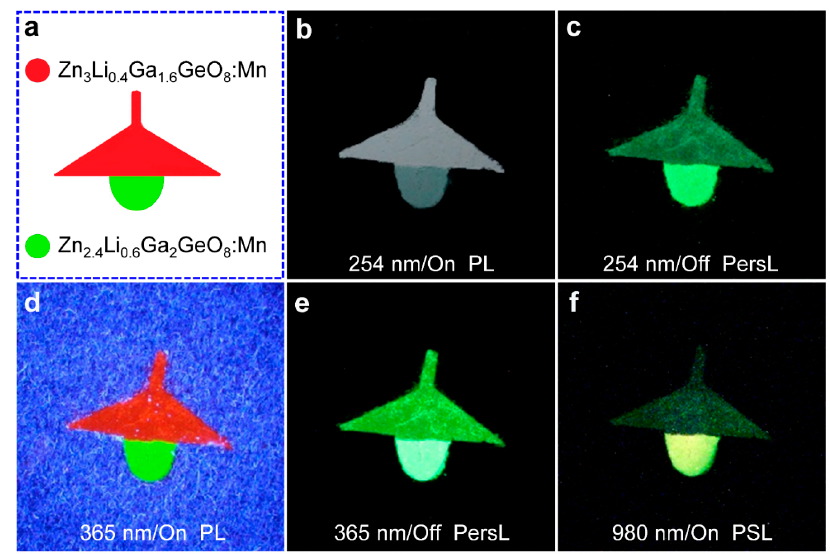
Figure 8. Digital photographs of a triple-mode (PL, PersL, and PSL modes) ‘chandelier’ pattern printed used Zn 3 Li 0.4 Ga 1.6 GeO 8 :Mn phosphor (lampshade) and Zn 2.4 Li 0.6 Ga 2 GeO 8 :Mn phosphor (light bulb) synthesized by hydrothermal approach. ( a ) The design of the ‘chandelier’ pattern; ( b , c ) PL and PersL images acquired upon and after 254 nm UV light excitation (for 5 min); ( d , e ) PL and PersL images acquired upon and after 365 nm UV light excitation (for 5 min); ( f ) PSL images upon a 980 nm laser diode irradiation (at 0.5 W). The PSL imaging was achieved until the disappearance of chandelier to the naked eye. The camera parameters are manual/ISO 3200/4 s.